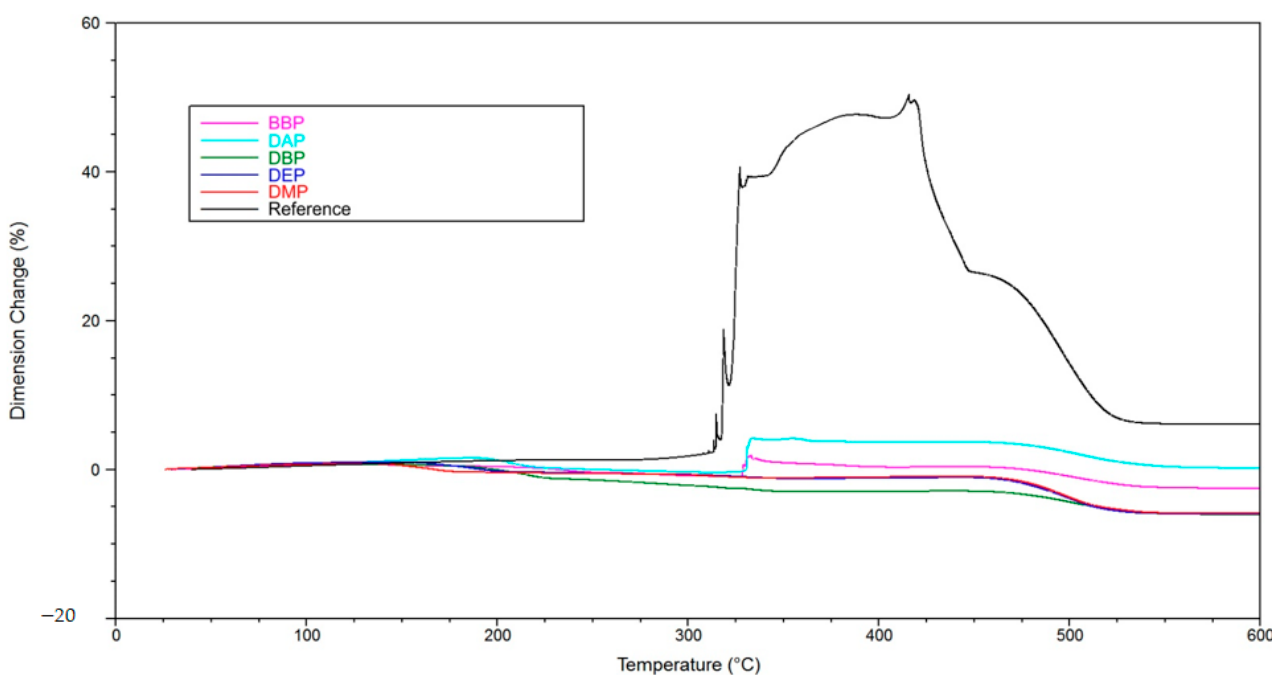
Figure 13. Thermomechanical analysis of green bodies produced by LCM using different phthalate suspensions.